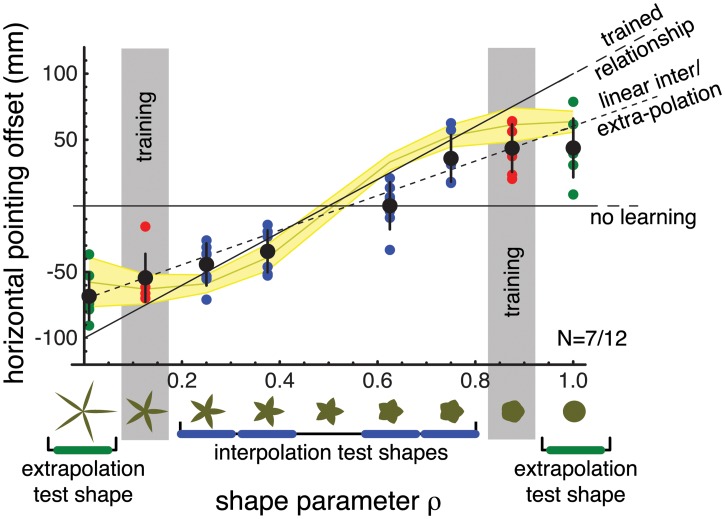
Generalisation results of Experiment 1.Results are shown for participants that learned the cued mappings (7 out of 12 participants). The x-axis indicates the training and test shape morph factors. The y-axis indicates the mapping that participants applied for each shape. The continuous horizontal and tilted black lines indicate the no-learning prediction and the trained linear relationship, respectively. The black dashed line indicates the prediction for linear inter/extrapolation based on the linear fits of the training results. Coloured disks indicate single participant results for the corresponding test shape (red, blue and green disks represent trained shapes, interpolation shapes and extrapolation shapes, respectively). Black circles and error bars indicate the mean and standard deviation across participants. The yellow line and shaded area show the Mixture-of-Kalman-Filters Model mean and standard deviation across participants. The results indicate that the learning for 2 trained shape-mappings pairs transfers to the other shapes on the same morph scale. Both linear generalisation and the Mixture-of-Kalman-Filters Model seem to capture the observed pattern of generalisation.